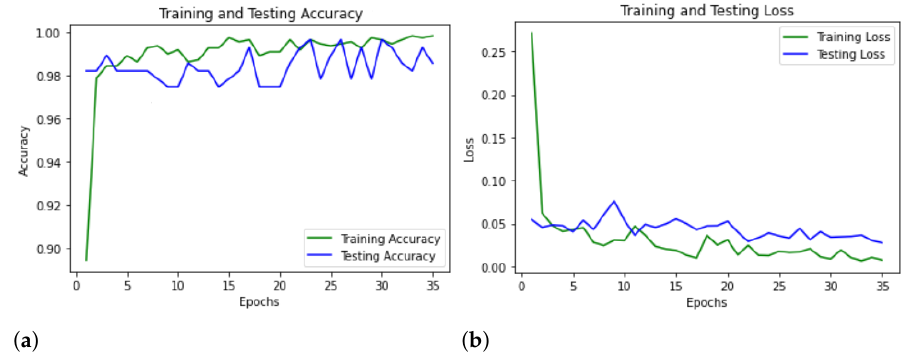
Figure 12. ( a ) Accuracy curve for training and testing, ( b ) Loss curve for training and testing. Table 3. Comparison of different dimension images of MobileNetV1 and MobileNetV2 implemented along with Caffe model.